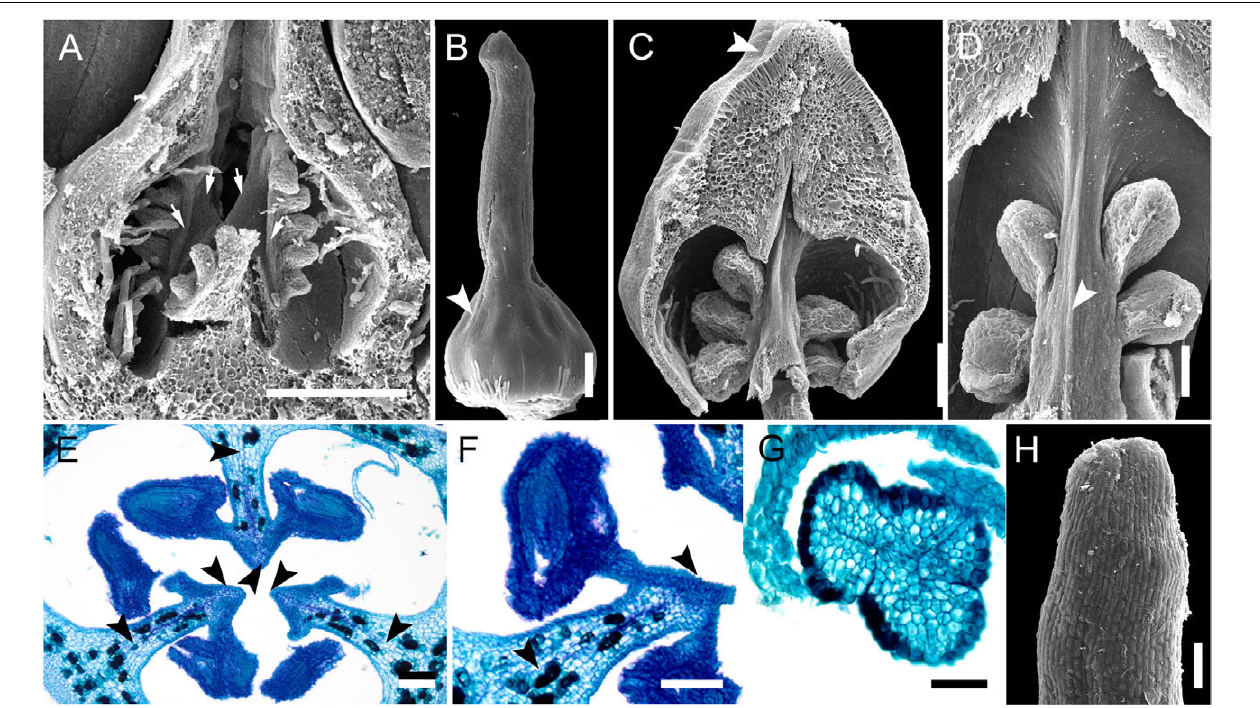
FIGURE 13 | Gynoecium development in Saxofridericioideae-Stegolepideae. Stegolepis cardonae, ovary development. (A) Young ovary dissected to show placentae in hemisymplicate zone, four of six carpel margins are visible (arrows). (B) Gynoecium at stage as in panel (A) . Lines of postgenital fusion can be traced from stigma down to ovary roof. (C) Later stage with postgenotally fused carpel margins in hemisymplicate zone. Note massive ovary roof. (D) Same stage as in panel (C) , boundary between two carpels, placenta. (E) Cross-section of ovary through hemisymplicate zone, stage similar to (C,D) . Incomplete septae are partly formed by postgenital fusion between initially free carpel margins. (F) Boundary between two carpels, slightly above (E) . (G) Section through postgenitally closed gynoecium tip, slightly below stigma. (H) Style tip. Arrowheads show visible boundaries and lines of postgenital fusion in asymplicate and hemisymplicate zones. Scale bars = 300 mkm in panels (A–D) , 100 mkm in panels (E,F,H) , and 50 mkm in panel (G)